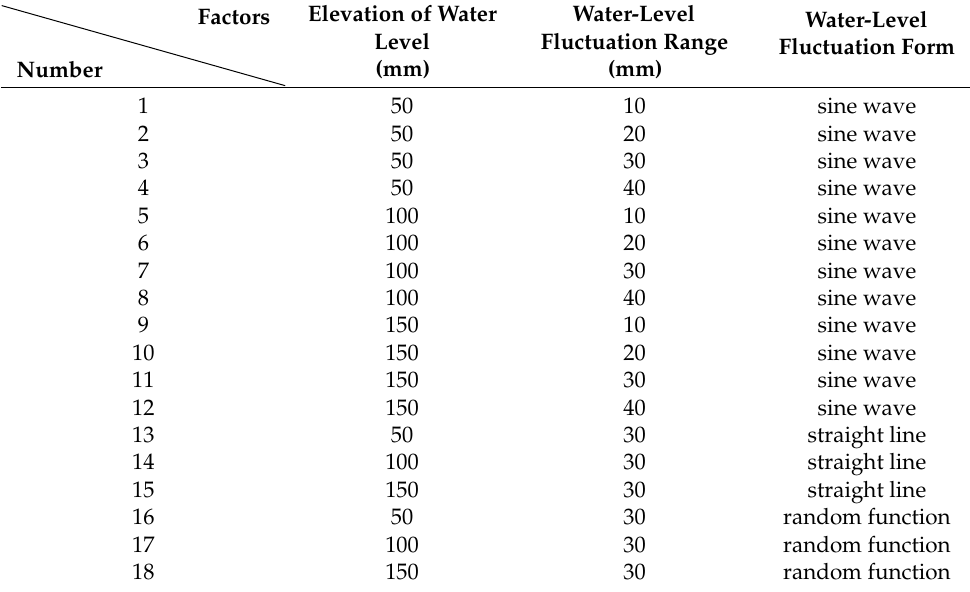
Table 3. Simulation of working